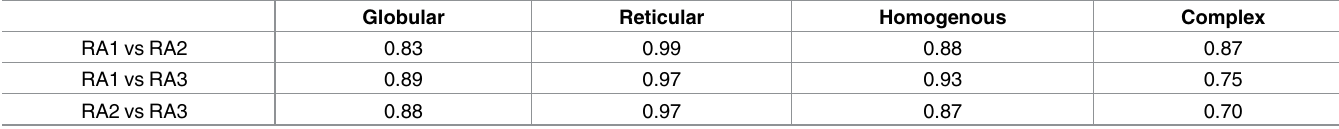
Table 3. Pearson correlation coefficients of 3 observers for counts of naevi of different dermoscopic patterns in 20